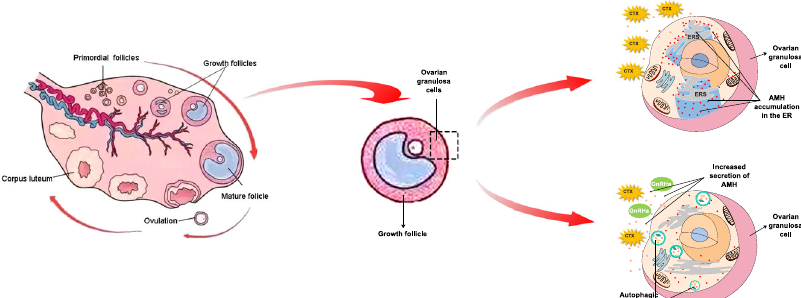
Fig. 1 Graphical abstract of the mechanistic study. Cyclophosphamide induces AMH accumulation in the endoplasmic reticulum (ER), further inhibits the secretion of AMH by induction of ER stress in ovarian granulosa cells, leading to depletion of ovarian reserve. GnRHa co- treatment alleviates ER stress by inhibiting the mTOR pathway to induce autophagy, which would ultimately result in AMH secretion. Secreted AMH arrives at the ovaries and protects the ovarian reserve, attenuating chemotherapy-induced ovarian dysfunction and preventing